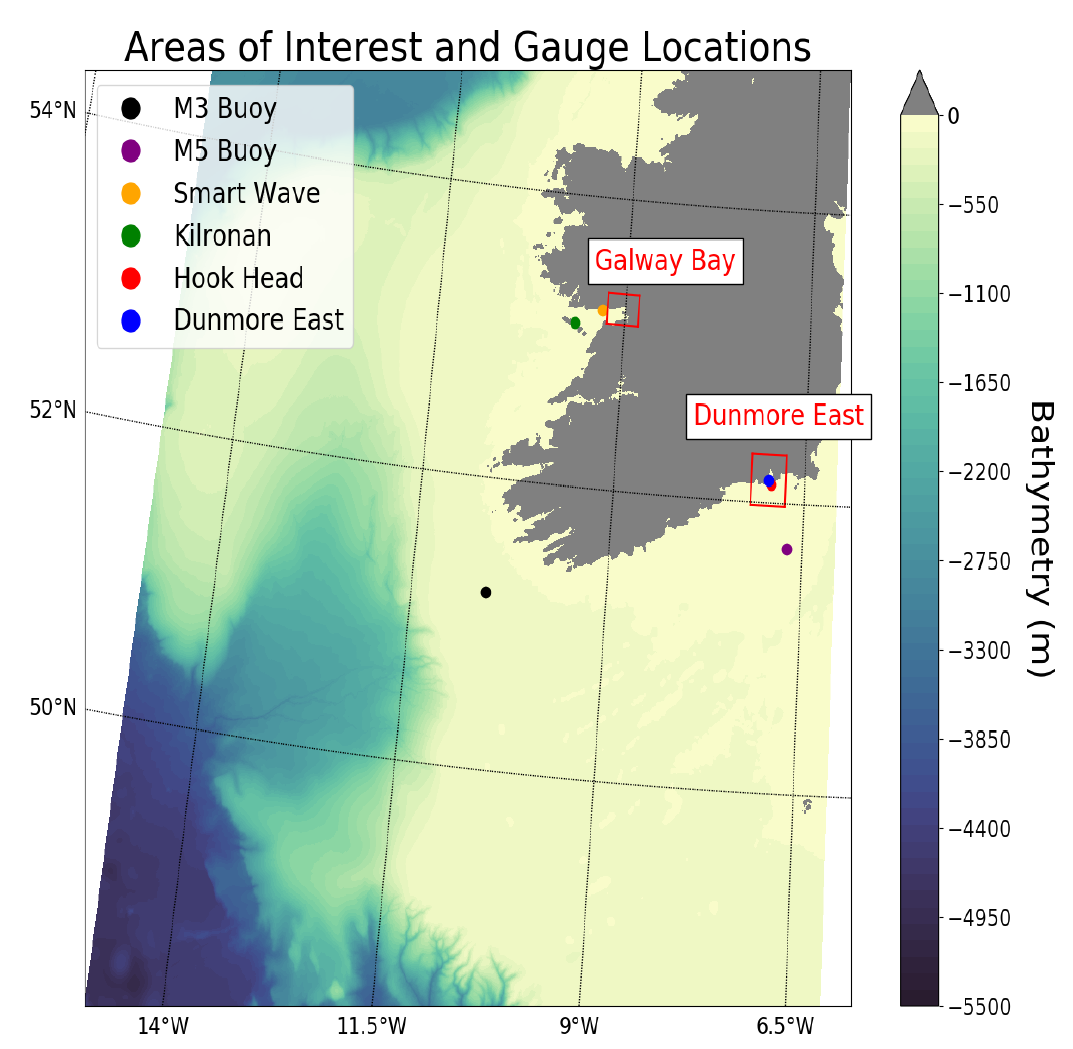
Figure 2. Zoom in on the bathymetry around the coast of Ireland, with the areas of interest: Galway Bay and Dunmore East highlighted by the red squares. The location of various wave gauges are highlighted by the coloured dots.